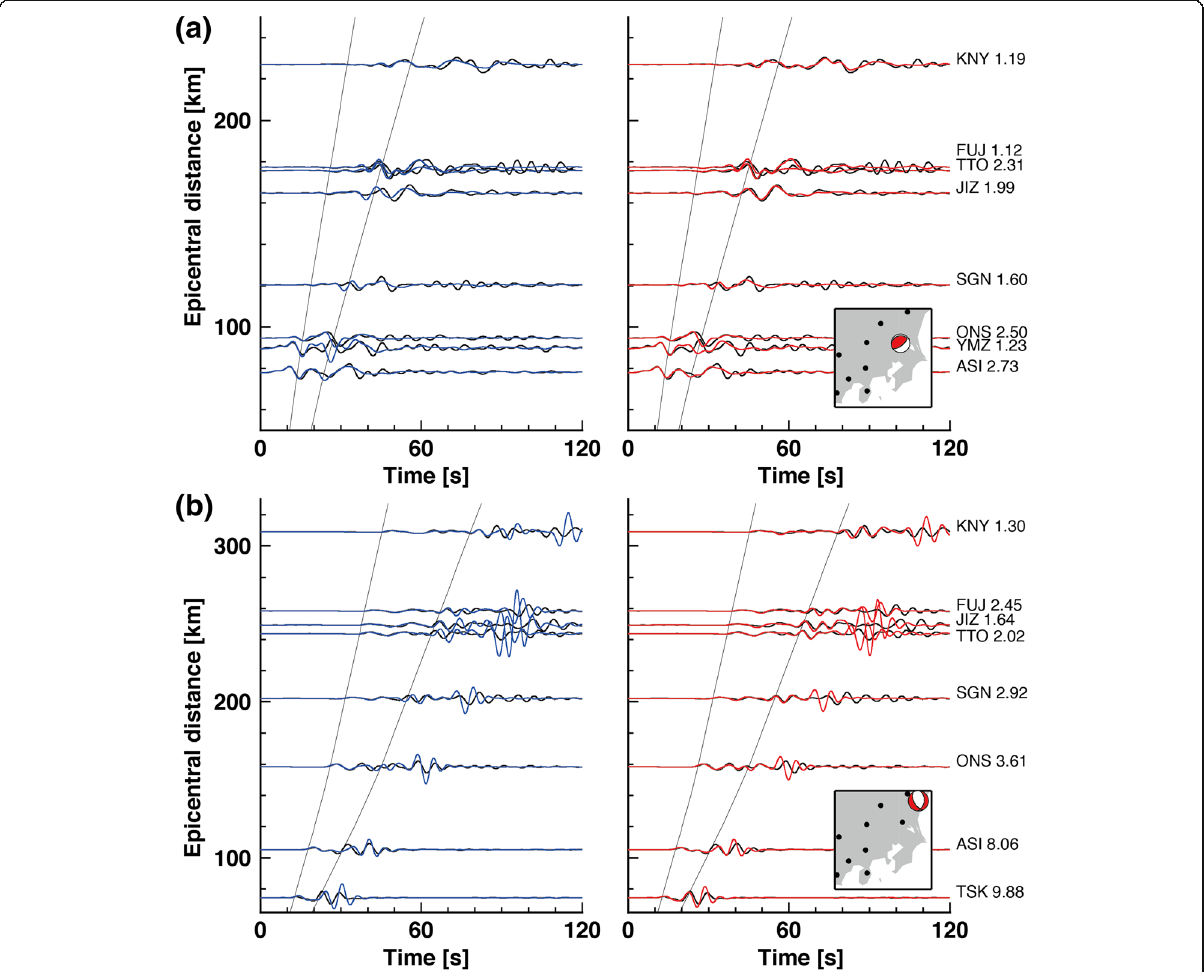
Fig. 15 Seismogram profiles of the data and extra events. a Vertical waveforms for the earthquake used in the inversion (June 2, 2007; M W 4.5). b Vertical waveforms for the extra earthquake not used in the inversion (Feb. 19, 2012; M W 4.9). Black traces indicate observed waveforms, and blue and red traces indicate m 00 and m 16 waveforms, respectively. The absolute maximum amplitudes (units: 10 − 6 m) are shown in the right panels. Black curves indicate the theoretical travel time curves of the P- and S-waves obtained based on a 1D model (Kubo et al. 2002). The CMT solu- tions and stations are also